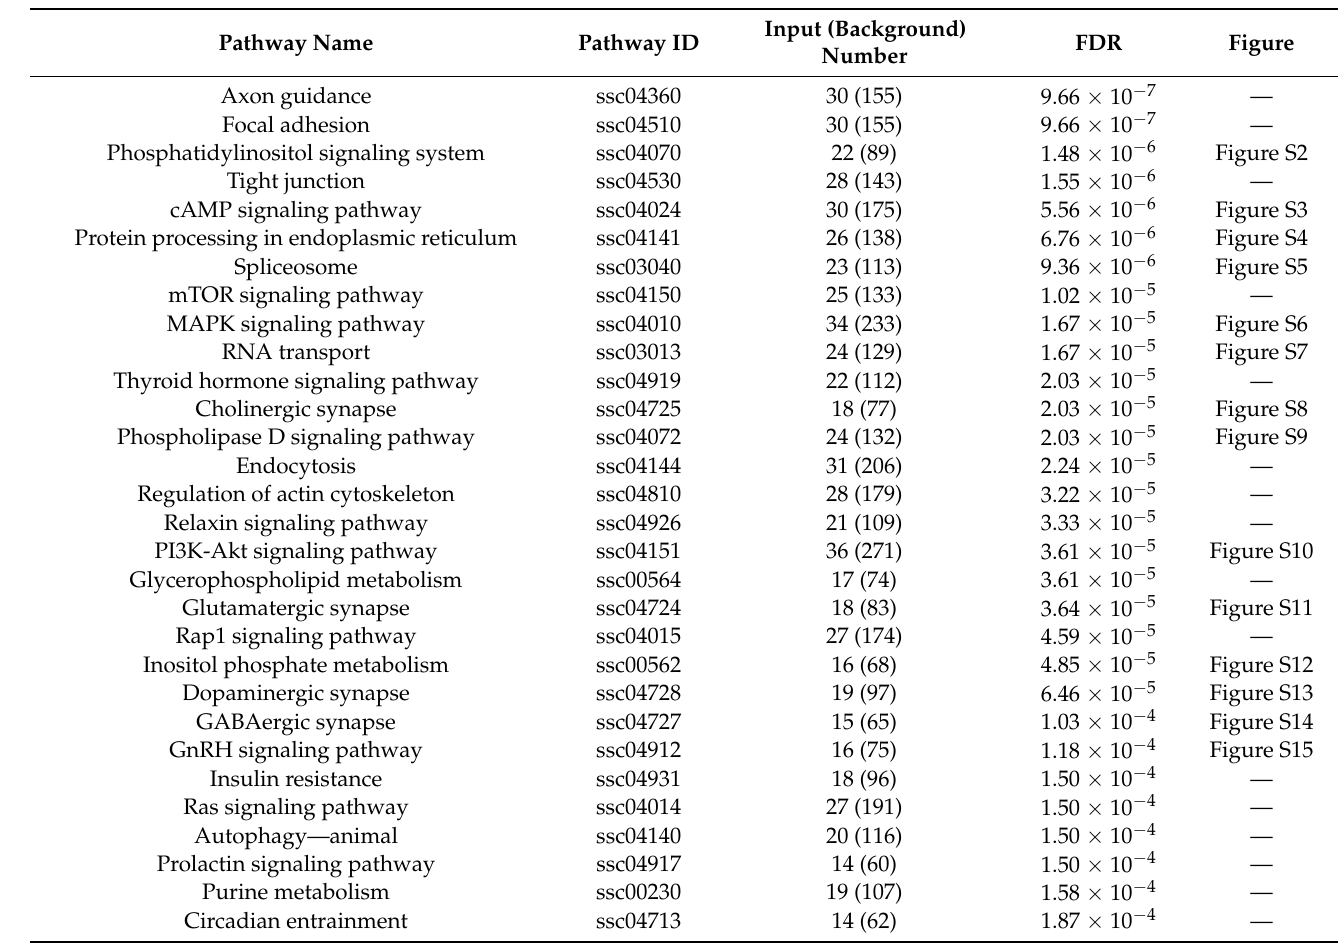
Table 2. Summary of KEGG pathways that are statistically implicated by identified DEGs; DELs associated with DEGs; and protein-coding genes associated with DASs, ASEs and differential RNA editing events in the porcine pituitary cells isolated during the embryo implantation period of pregnancy and the mid-luteal phase of the estrous